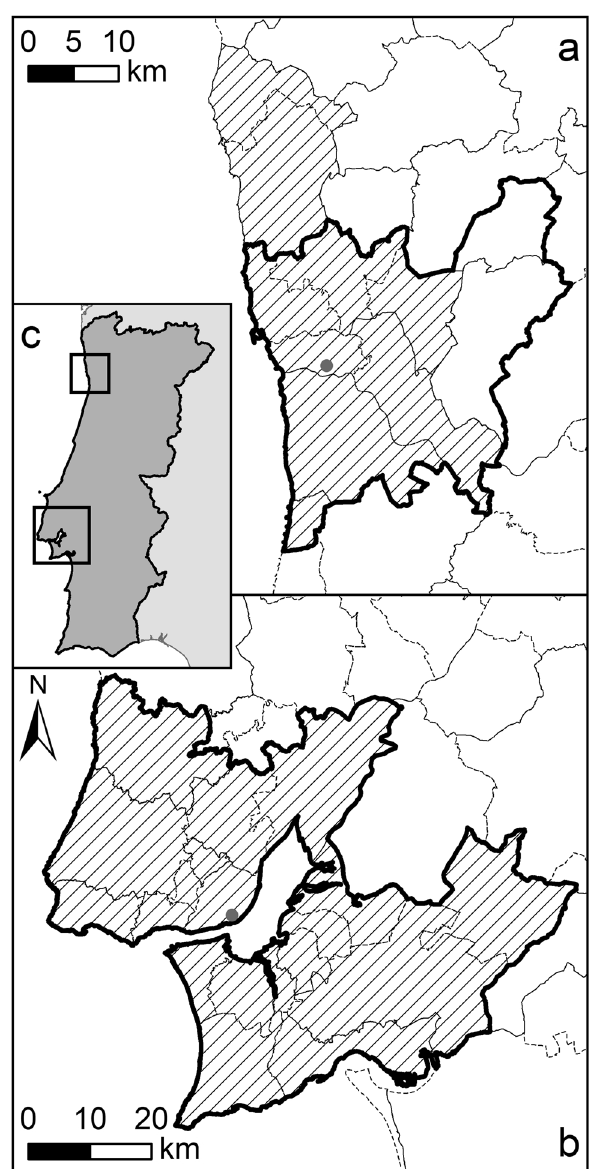
Figure 4. Estimation of Metropolitan Area boundaries for Porto ( a ) and Lisbon ( b ). Dashed lines represent the municipality boundaries; grey points are the locations of each urban agglomeration provided by WUP dataset; the solid black lines show the estimated boundaries by means of ‘GHS-SmartDissolve’ tool, imposing as target for polygon aggregation the reaching of 95% of WUP 2011 population (i.e. 5% tolerance to accommodate eventual small discrepancies between WUP and census data); striped areas are the actual Metropolitan Areas of Porto and Lisbon in 2011. ( c ) The locations of the areas represented with ( a ) Porto (upper rectangle) and ( b ) Lisbon (lower rectangle) in Portugal mainland. Map produced by the authors using ArcMap (Esri) 10.8